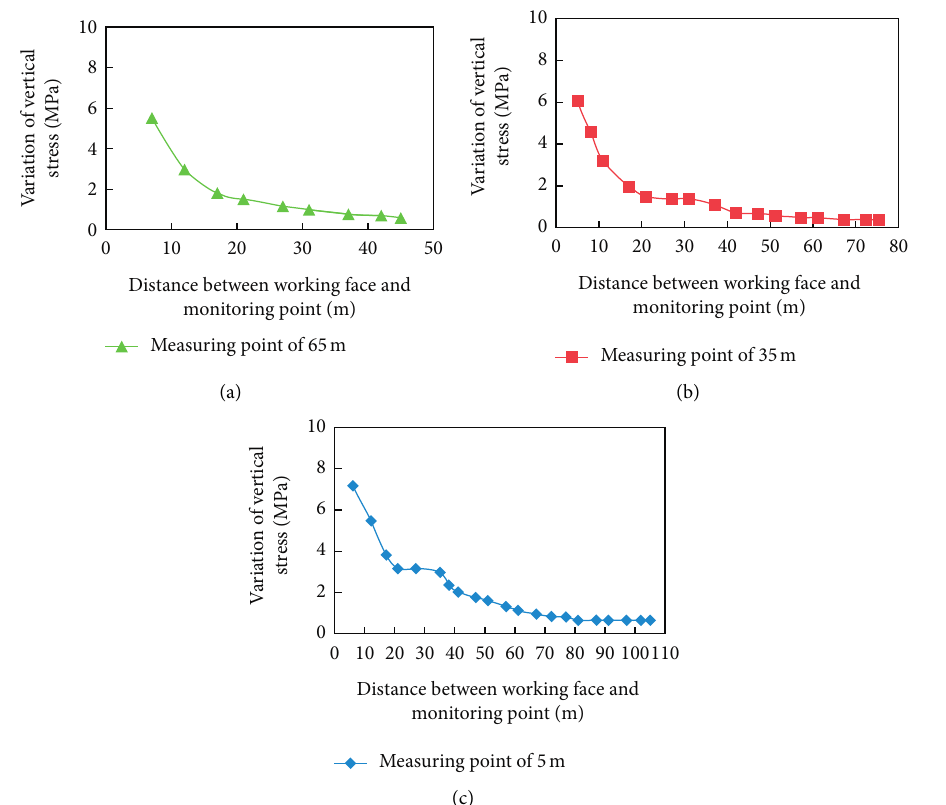
Figure 16: Borehole stress with working face advancing in Xinchun coal mine. (a) Change of coal stress at 65m monitoring point. (b) Change of coal stress at 35m monitoring point (c) Change of coal stress at 5m monitoring